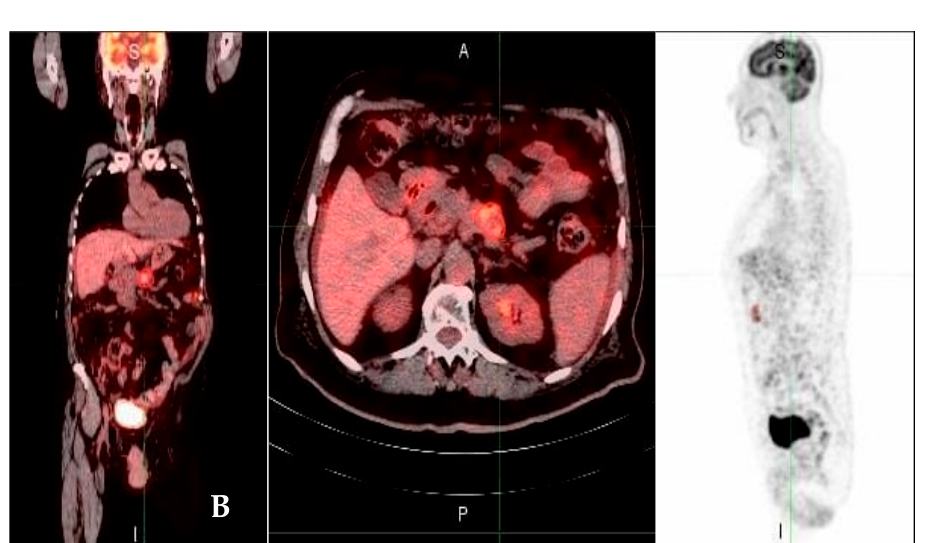
Figure 1. A 66-year-old man was diagnosed with stage II pancreatic adenocarcinoma (T3N0M0). PET/CT scans performed at baseline reveal minor metabolic activity (yellow regions, ( A , B ); maxi- mum standardized uptake value, 3.7) consistent with primary pancreatic mass; projection of maxi- mal intensity PET imaging demonstrates 33 mL of tumor glycolytic activity without signs of meta- static involvement (pancreatic body mass).